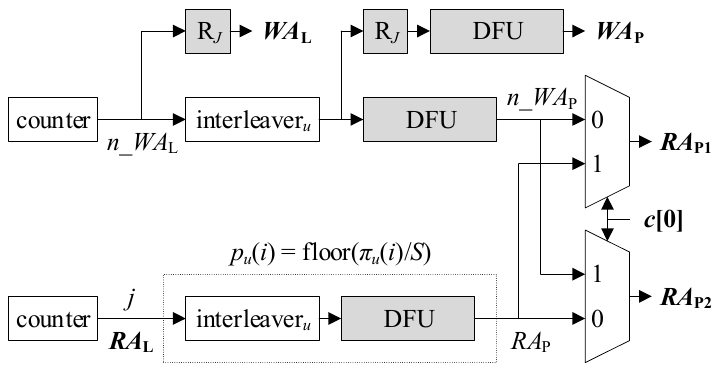
Figure 3. Sequential-address-based AGU (S-AGU).